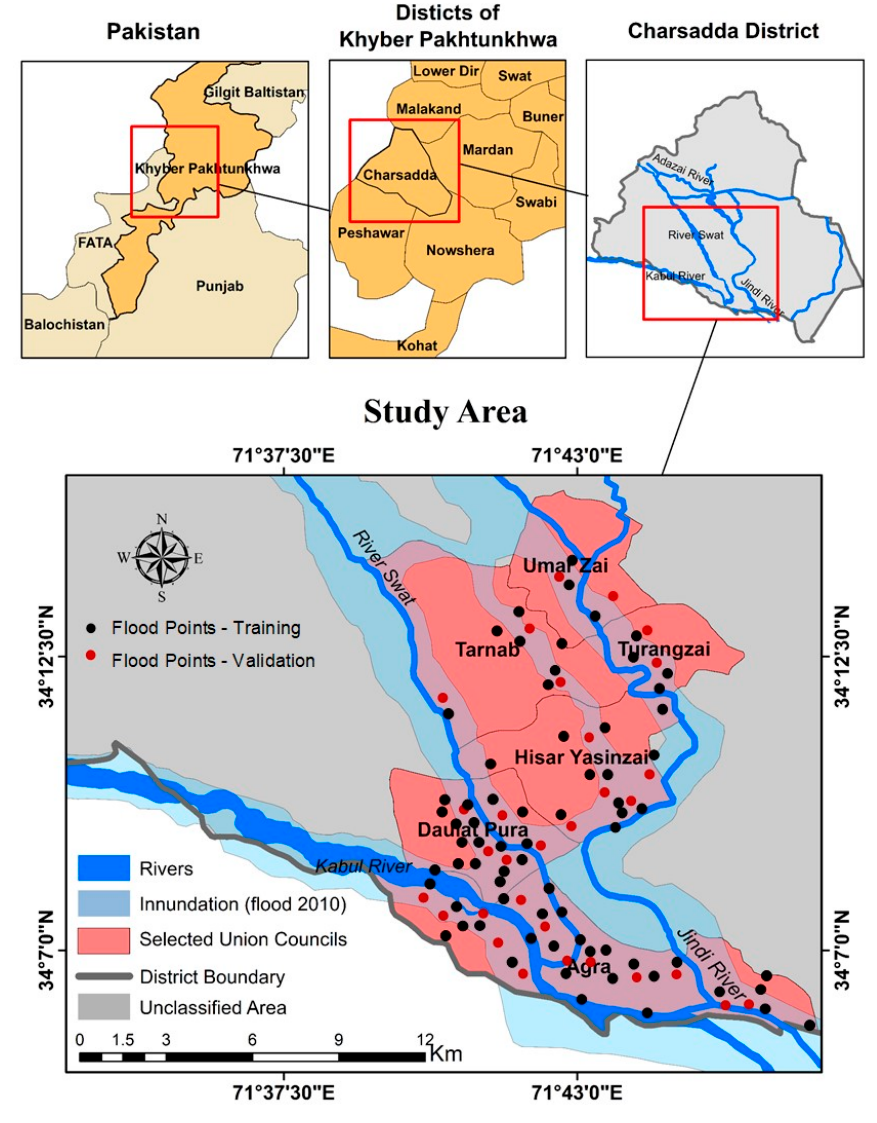
Figure 1. Reference map of the study area.